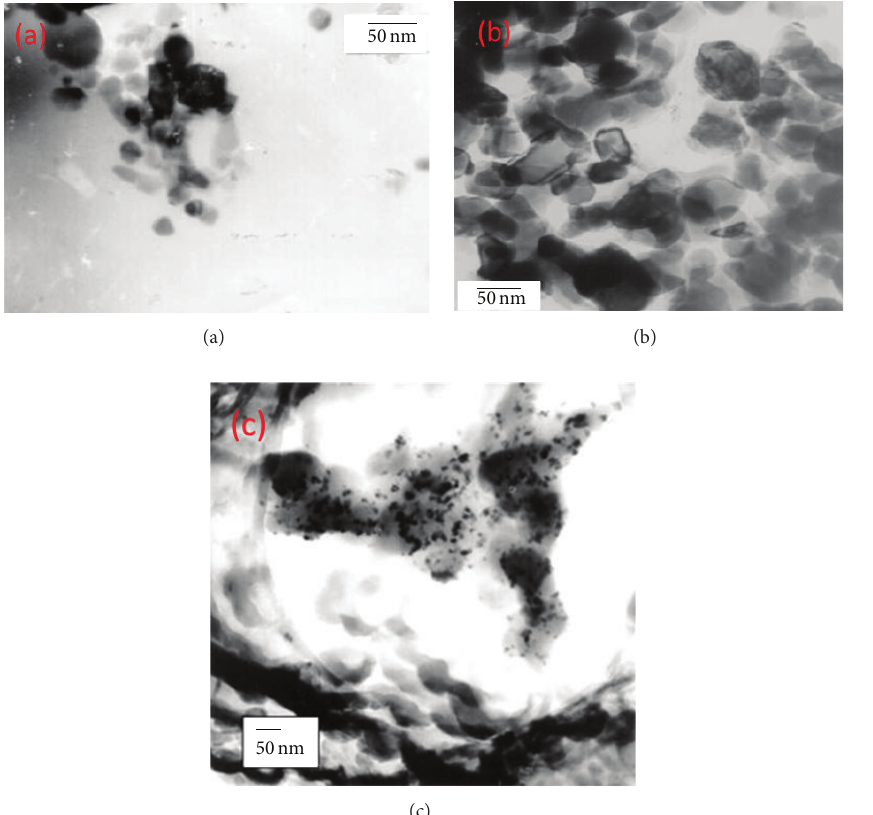
Figure 4: (a) TEM micrograph of Co/TiO 2 (673)-I catalyst after reduction-oxidation-reduction cycle at 773-623-623 K. (b) TEM micrograph of Co/TiO 2 (973)-I catalyst after reduction-oxidation-reduction cycle at 773-623-773. (c) TEM micrograph of Co/TiO 2 (673)-SG catalyst after reduction-oxidation-reduction cycle at 773-623-773 K